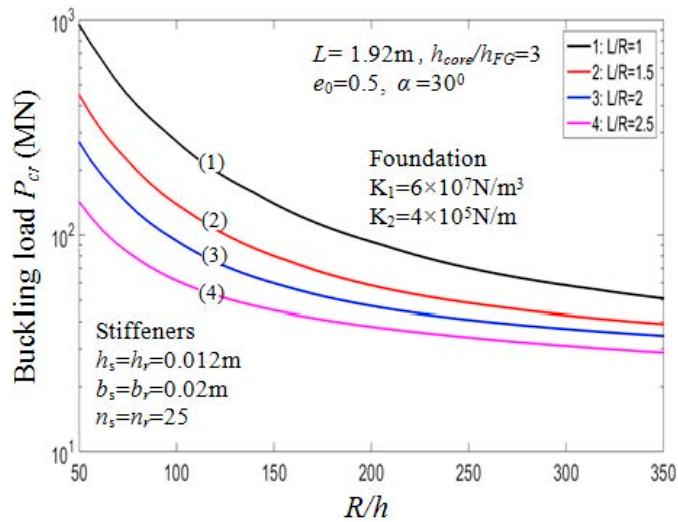
Figure 8. Effects of R / h and L / R on critical load P cr (Case 1, k 2 = k 3 = k = 1).